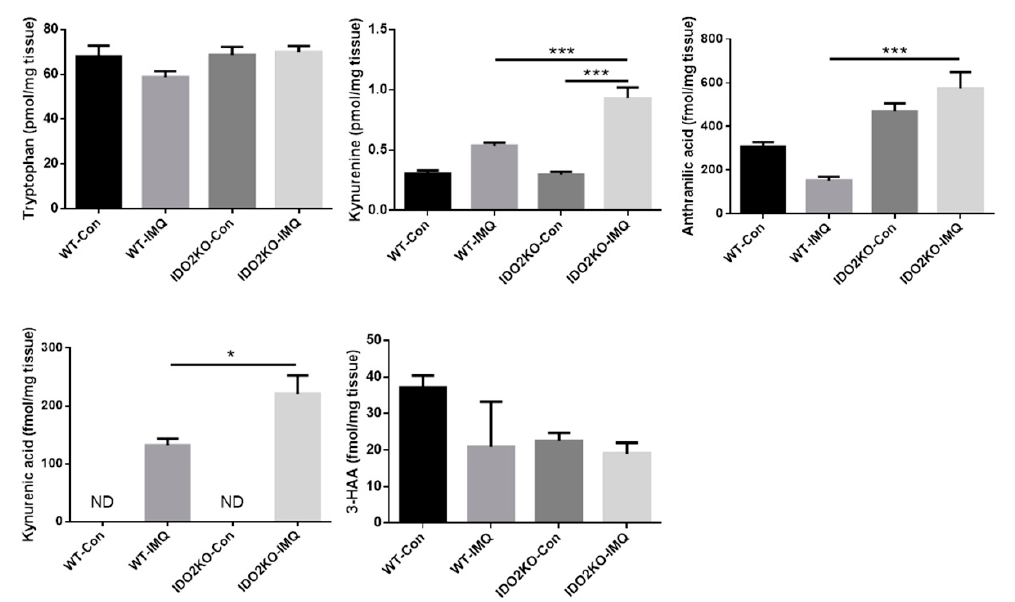
Figure 5. The concentration of tryptophan metabolites is higher in IMQ-treated IDO2 KO mice than WT mice. The concentration of tryptophan, kynurenine, kynurenic acid, anthranilic acid, and 3-HAA in the ears of WT and IDO2 KO mice with vehicle or IMQ treatment for 7 days were measured by high performance liquid chromatography. Data are presented as mean ± SEM. * p < 0.05, *** p < 0.001 (one-way ANOVA). Control groups, n = 4; IMQ-treated groups, n = 7. 3-HAA: 3-hydroxy anthranilic acid, ND: not-detected, WT: wild type, IDO : indoleamine 2,3-dioxygenase , Con: control, IMQ: imiquimod, KO: knockout.